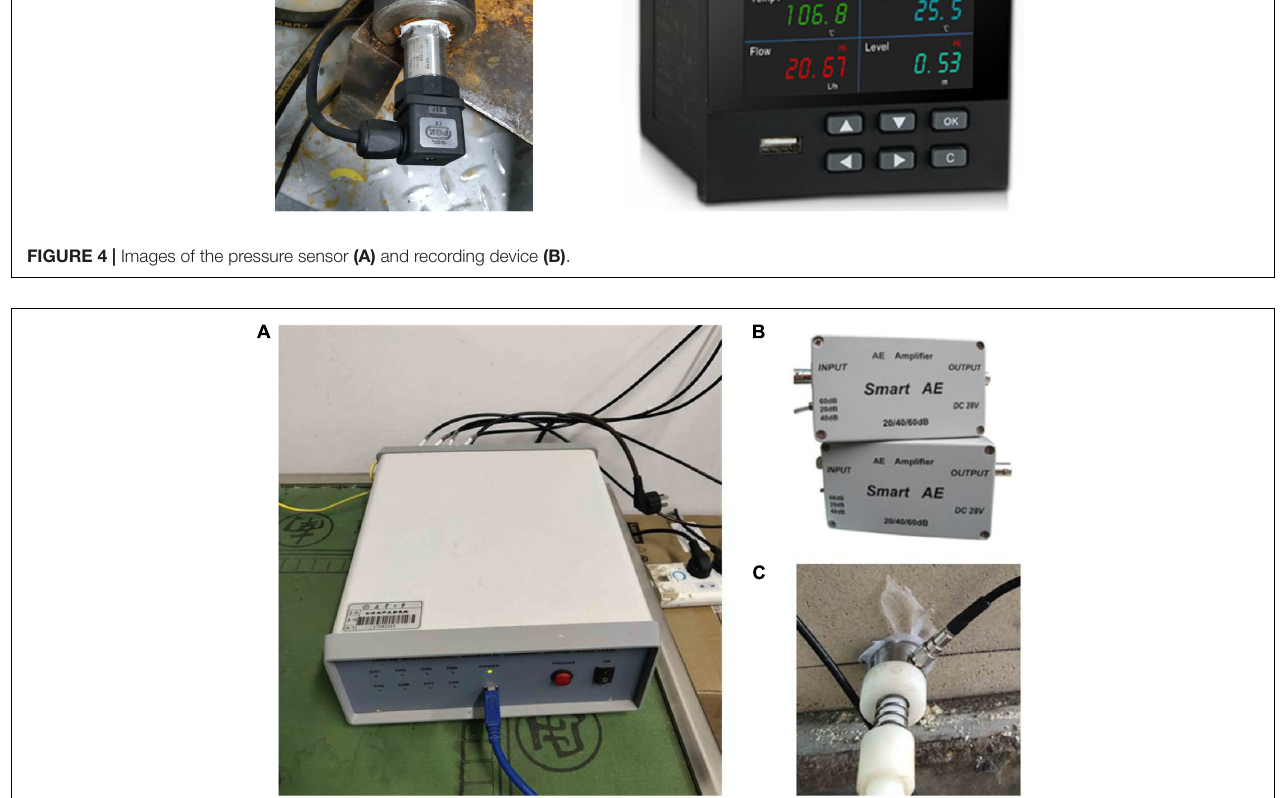
FIGURE 5 | Images of the acoustic emission equipment: (A) main body; (B) amplifier, and (C) probe.